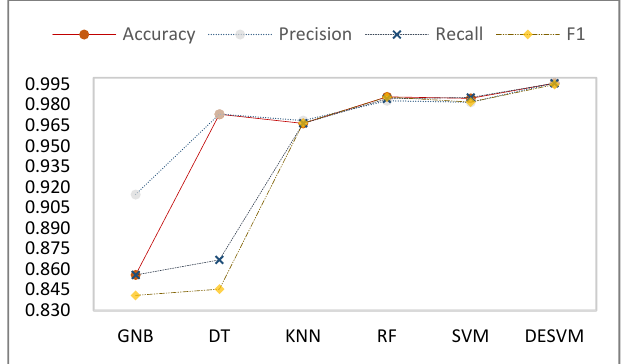
Figure 7. Comparison of experimental results of comprehensive evaluation indicators of six algorithms.